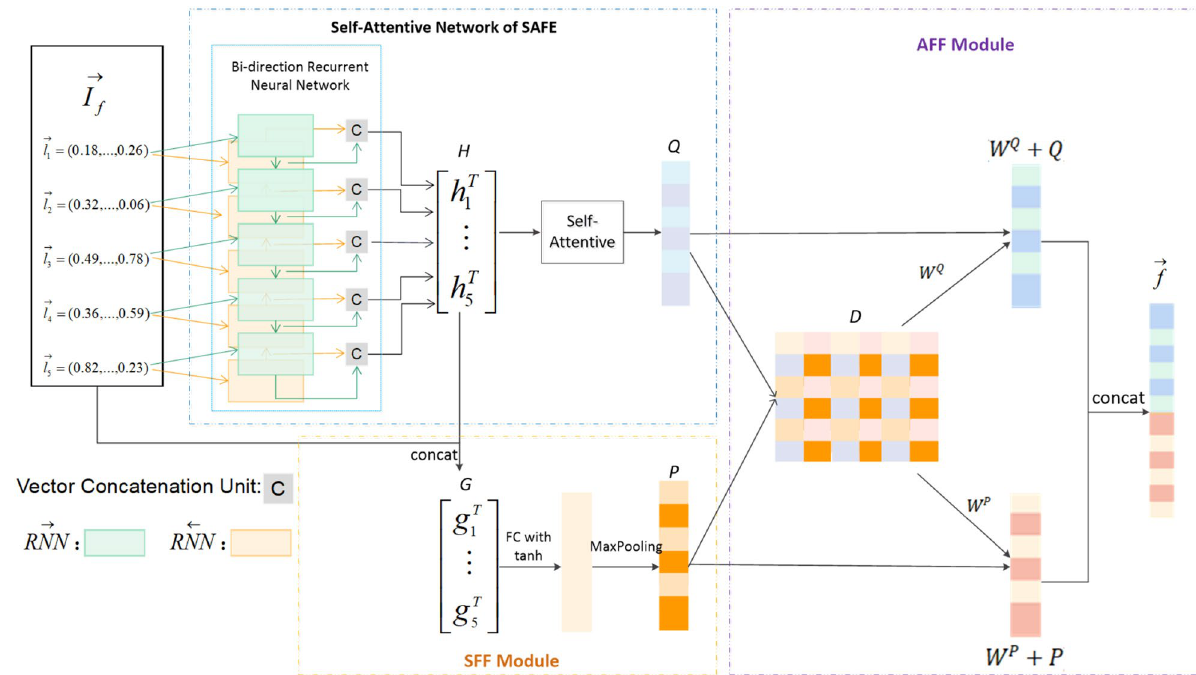
Figure 3. The overall framework of